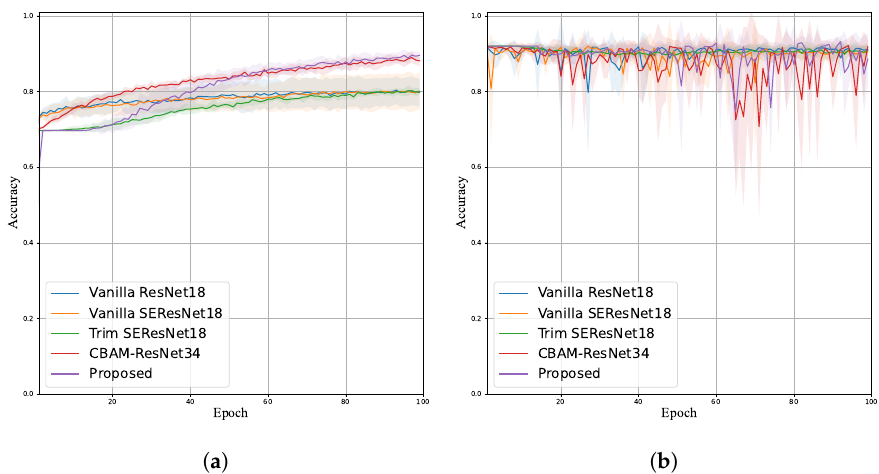
Figure 6. ( a ) Training and ( b ) Validation accuracy curves of the A-DSSS evaluation.